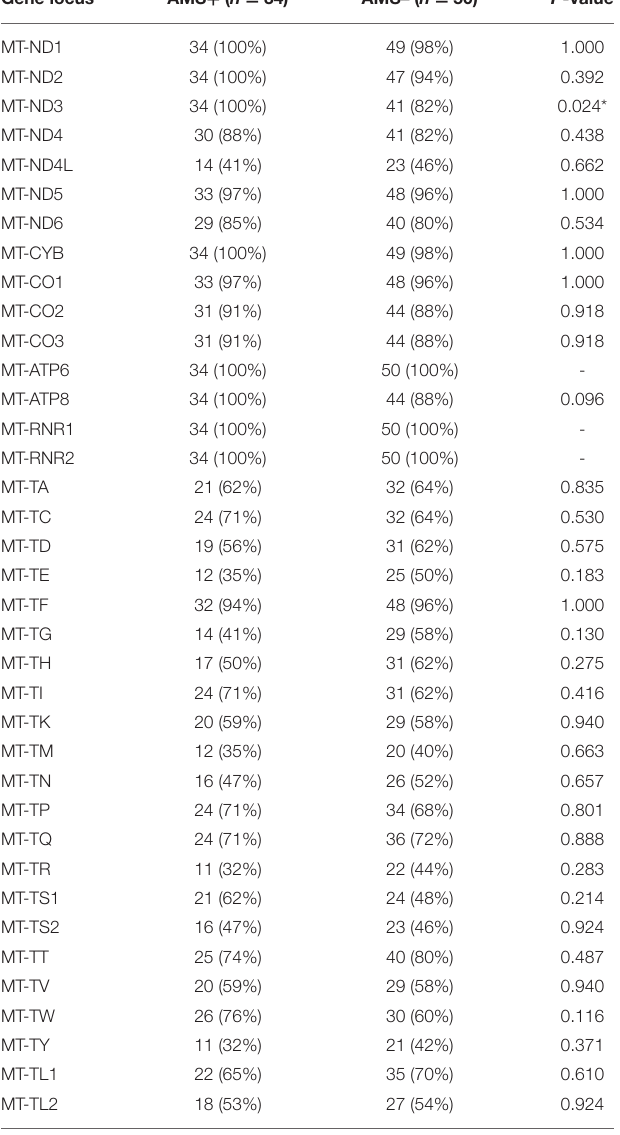
TABLE 7 | Comparison of mitochondrial gene mutation rates between the two groups. Gene locus